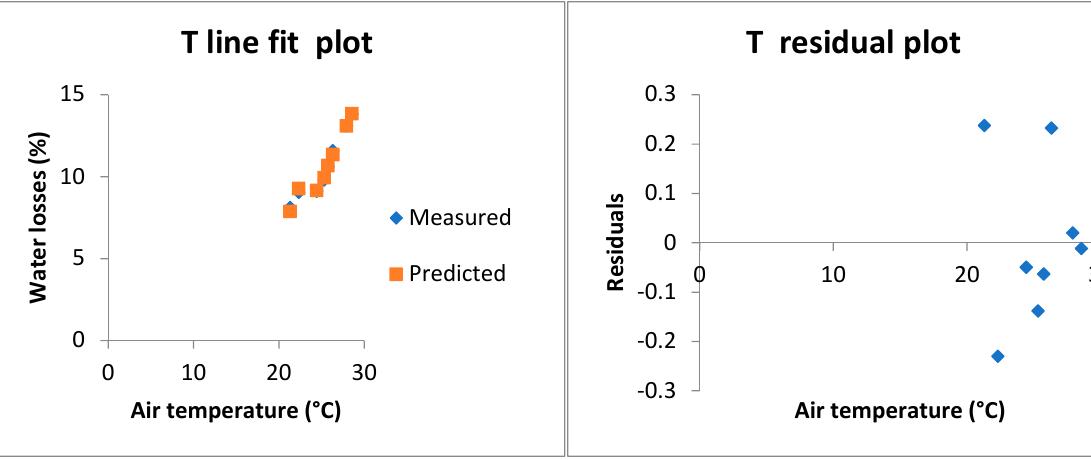
Figure 11. Measured and predicted water losses of the MLR model using the air temperature (T) dataset.